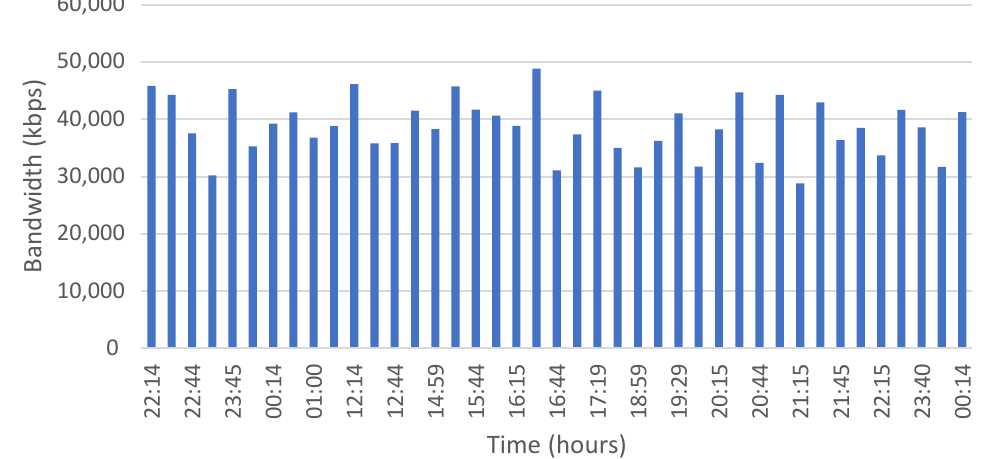
Figure 13. Bandwidth consumed uploading ROS bag files to a cloud storage (in the order of tens of